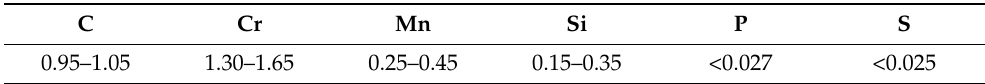
Table 2. Mechanical properties of bearing steel AISI 52100 [40].